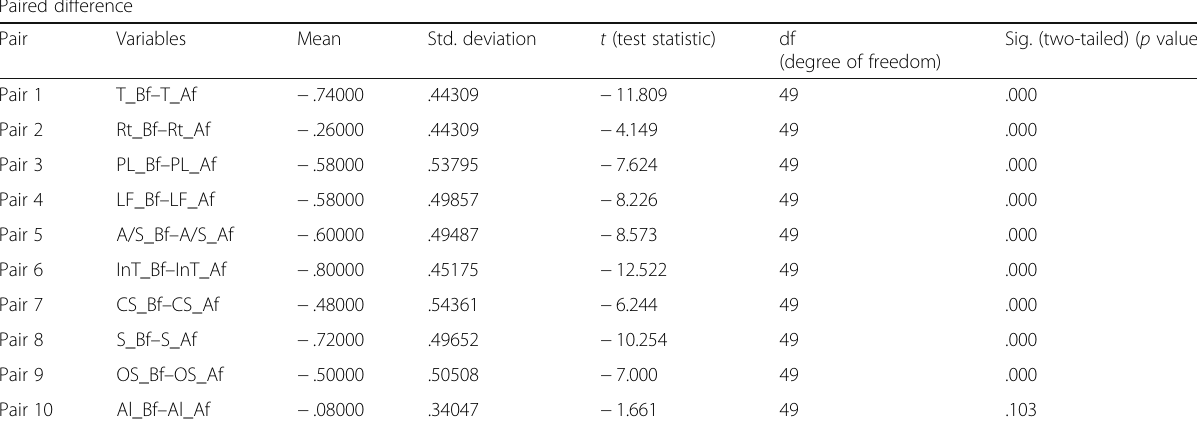
Table 3 Paired samples t test showing significance values in case of old age